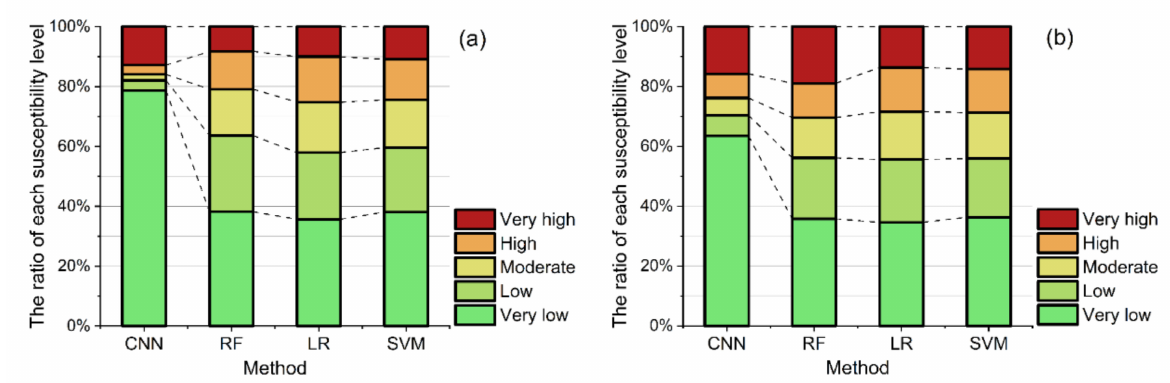
Figure 12. Landslide susceptibility zones for ( a ) Zhangzha Town and ( b ) Lantau